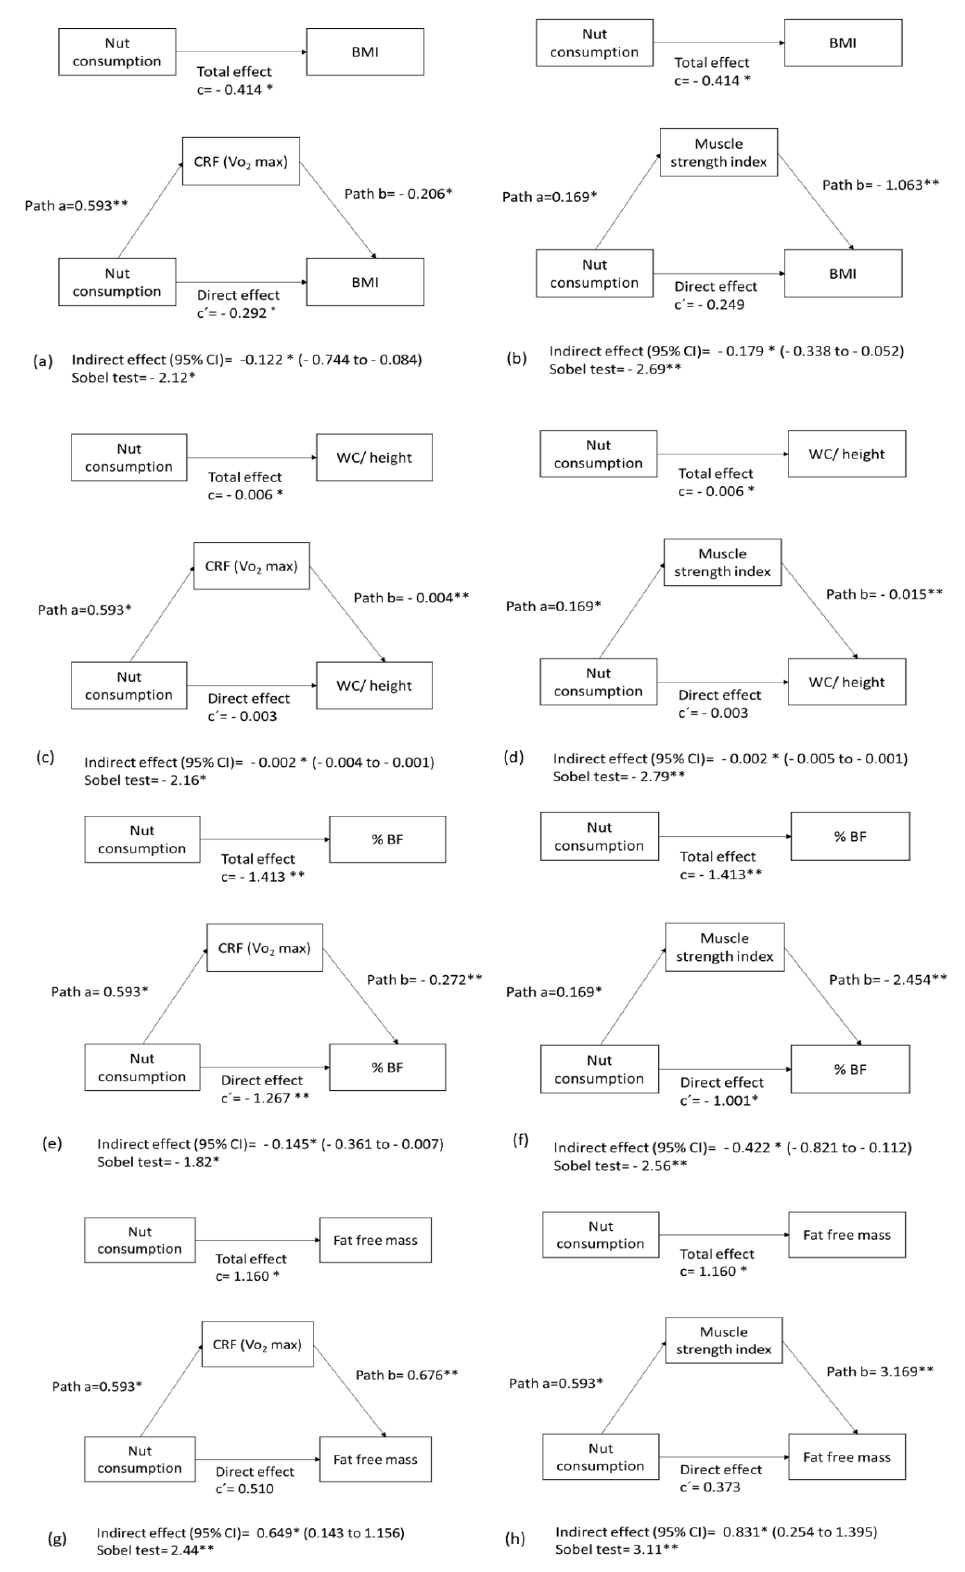
Figure 3. CRF (VO2 max estimate)/muscle strength index mediation models of the relationship between nut consumption with ( a , b ) BMI, ( c , d ) WC/heigh, ( e , f ) %BF, and ( g , h ) fat free mass controlling for age and sex. * p < 0.05, ** p < 0.001.